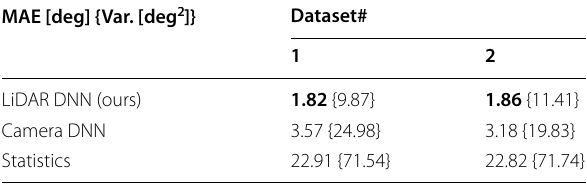
Bold value represents the best result in each experiment/validation Table 5 MAE and variance of static estimation on real data MAE [deg] {Var. [ deg 2 ]}